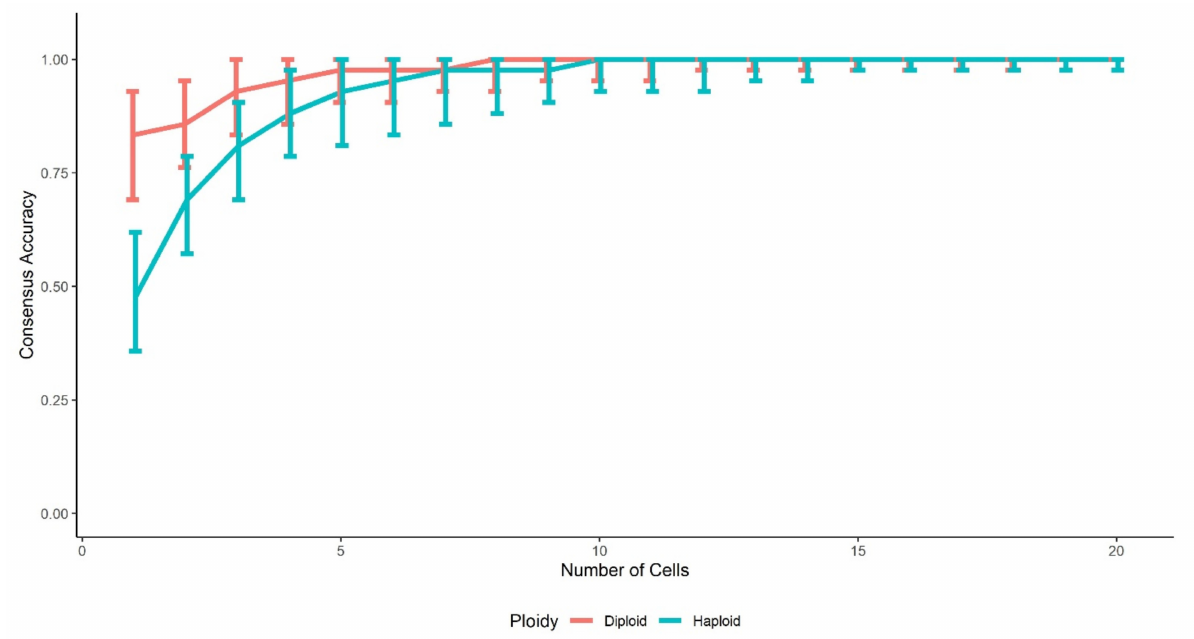
Figure 4. Consensus accuracy as a function of the number of cells in the cluster, with 1:1 ratio mixtures. D = 0.2; e = 0.01; 10,000 simulations for each mixture. The bars represent the 95% confidence